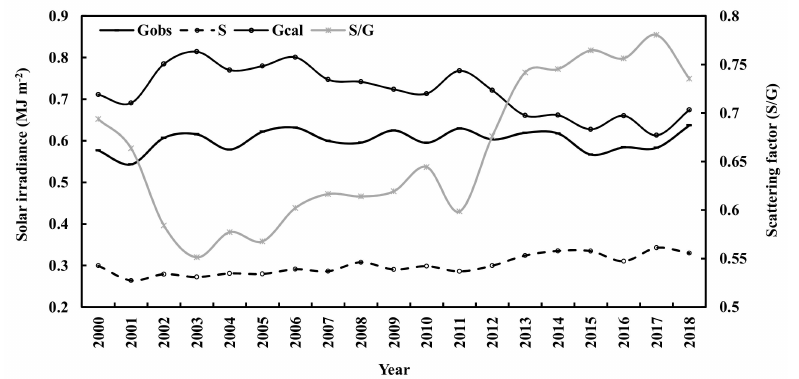
Figure 6. Annual global solar irradiance calculated and observed (G), observed diffuse irradiance (S) and scattering factor (S/G) at Sodankylä.